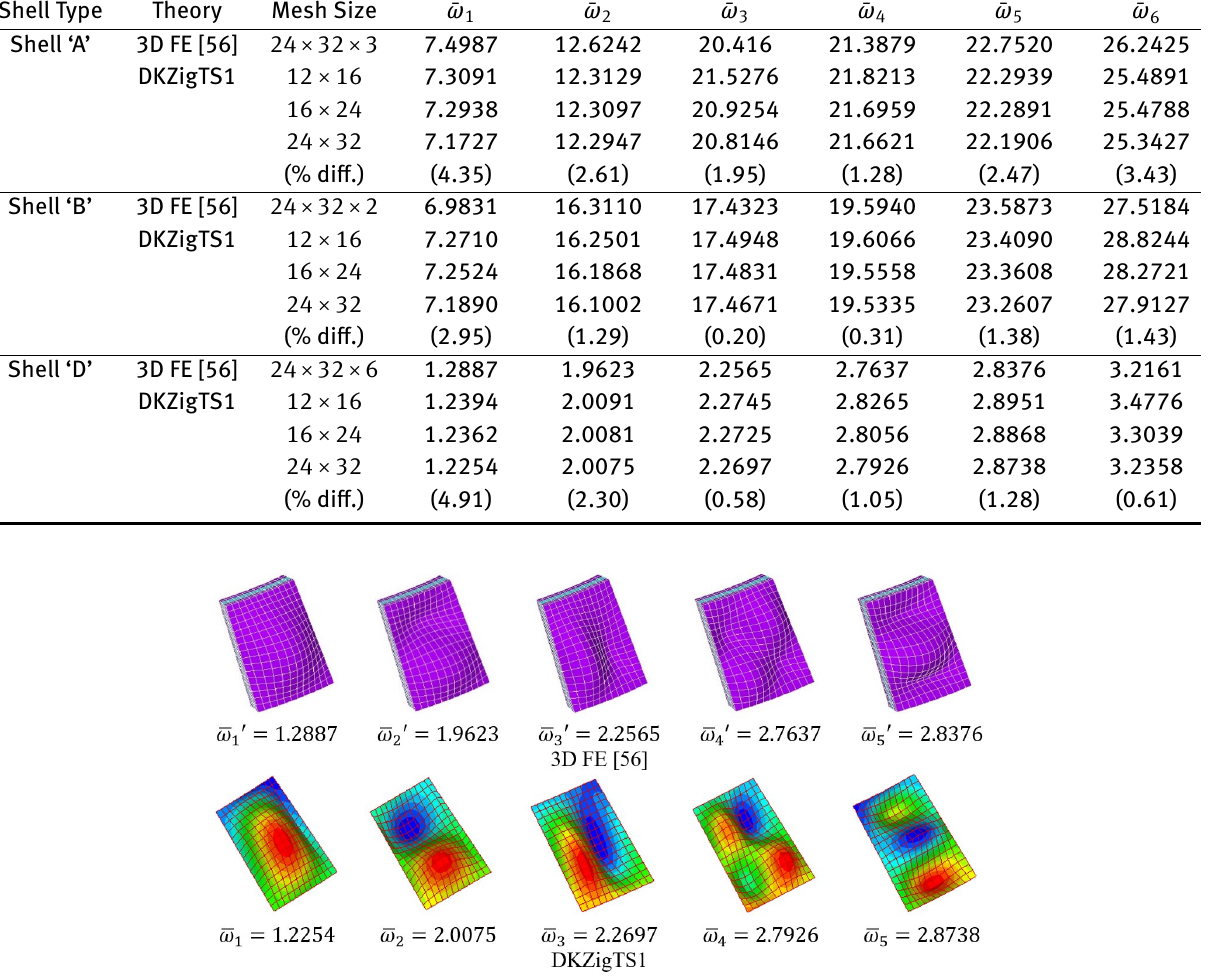
Table 9: Non-dimensionalised natural frequencies ¯ ω for an all-round simply supported composite and sandwich conical shell panels with h / L = 0.125 , S / L = 10 , 𝛾 o = 15 ∘ and 𝛾 v = 30 ∘ Shell Type